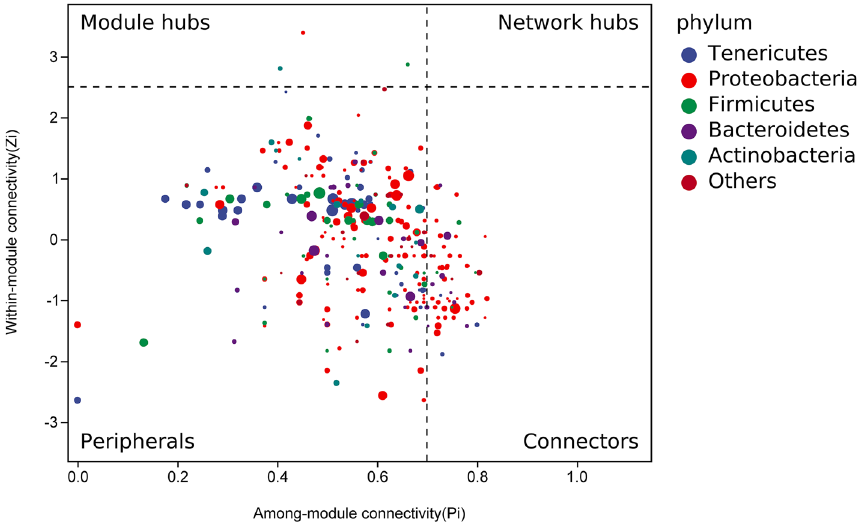
Figure 4. Network analysis of gut bacteria at the phylum level. The role of each node in the associated network is determined according to the values of Zi and Pi score. Zi module connectivity, Pi module